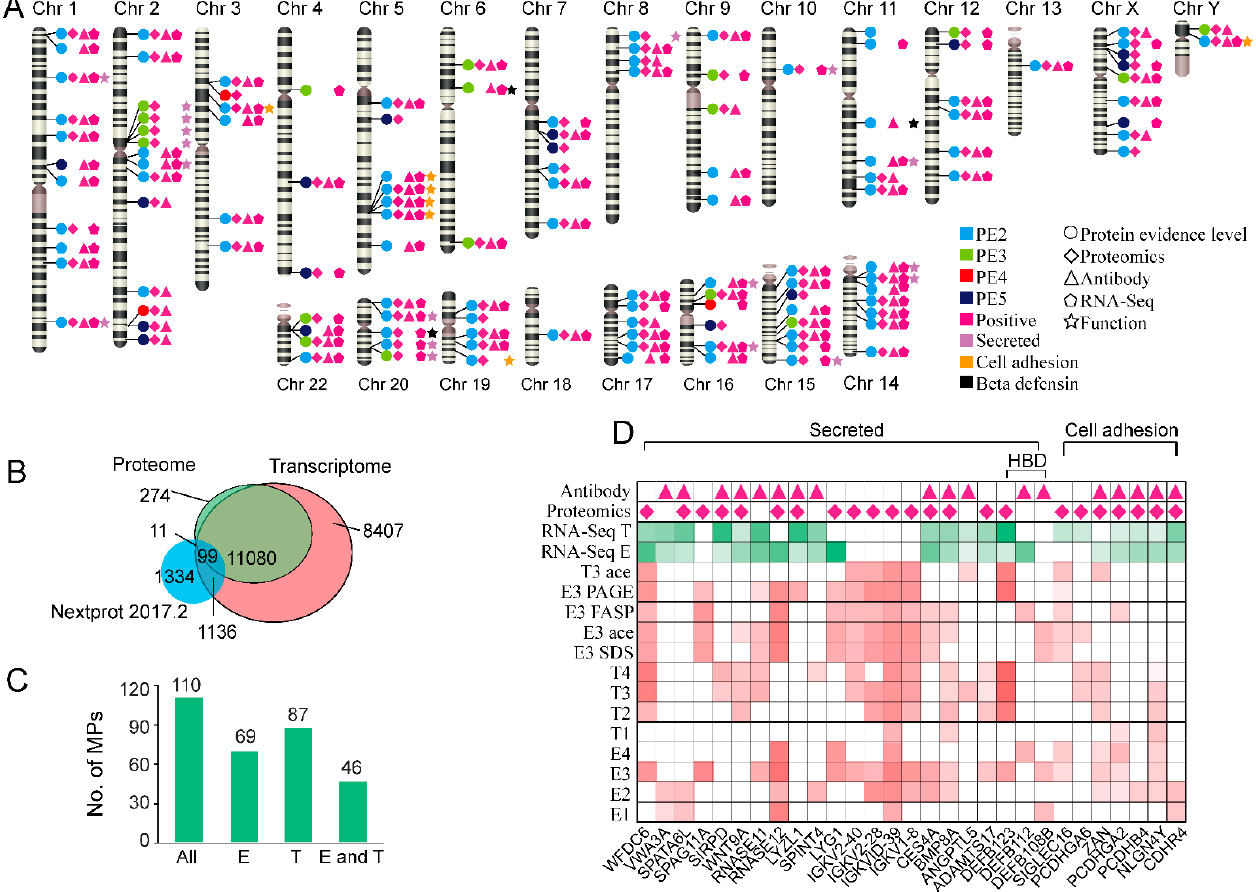
Figure 5. Proteomics analysis of missing proteins. ( A ) The distribution of the identified missing proteins on chromo- somes; ( B ) Venn diagram of testis and epididymis with the database; ( C ) The number of missing proteins in both tissues; ( D ) Functional analysis of genes identified by transcription groups to missing proteins and their comparison with data; and identification results and functional analysis of missing proteins in each sample. The depth of the red color represents the protein expression, and the green squares in the figure represent the amount of expression of transcription groups in both tissues.